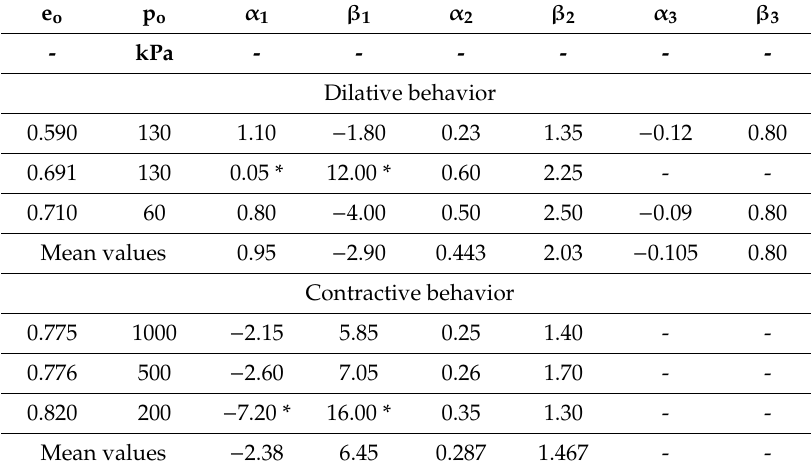
Table 1. Initial state and frictional state parameters for tests of Erksak